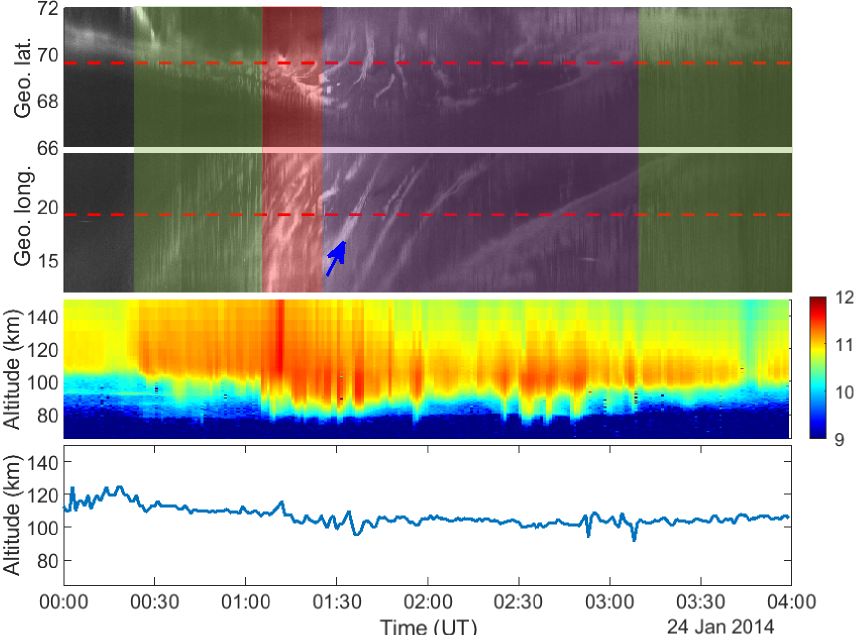
Figure 2. Keogram, ewogram, EISCAT electron density, and altitude of maximum electron density on 24 January 2014. The dashed red lines are the latitude and longitude of the EISCAT radar’s FOV. PsA types – APA (green), PPA (red), and PA (purple) – are marked with rectangles in the keograms and